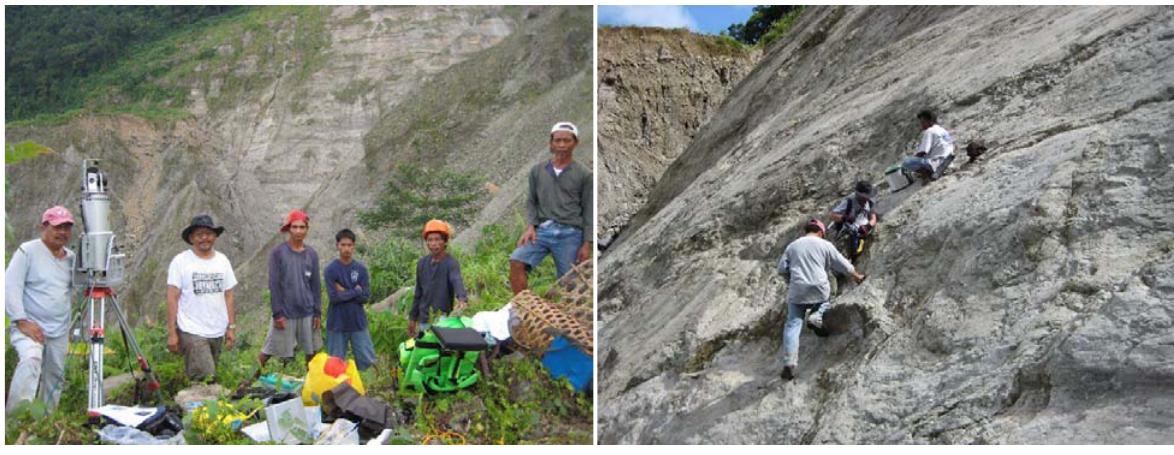
Figure 1. LiDAR survey crew (left) and manual survey crew installing the reflex targets on the slip surface of the February 17, 2006 landslide in Guinsaugon, Southern Leyte, Philippines, photos courtesy Professor Guitierrez and Riegl